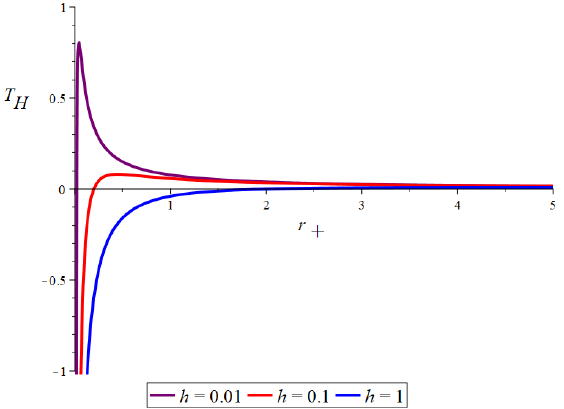
Figure 2: Plot of the Hawking radiation tempera- ture as a function of r + . We let h = 1 (blue), 0 . 1 (red), and 0 . 01 (purple). T H has a maximum value √ √ 6 of 5 − 2 when r + = (2 + 6) h . It then quickly 4 πh becomes 0 when r + = 2 h , turning negative when r + < 2 h